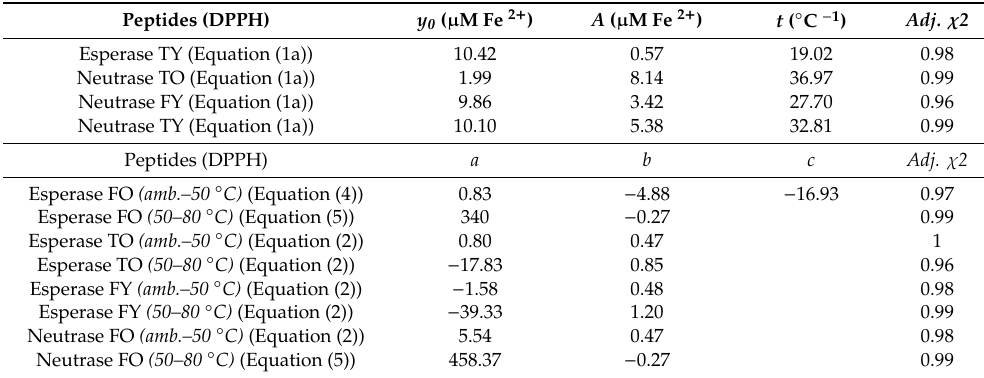
Table 7. Kinetic parameter for the DPPH • quenching models and model adjustment (Adj. χ 2 ) for neutrase and esperase. FO = old femur, 10 years; TO = old tibia, 10 years; FY = young femur, 4.5 years; TY = young tibia, 4.5 years.